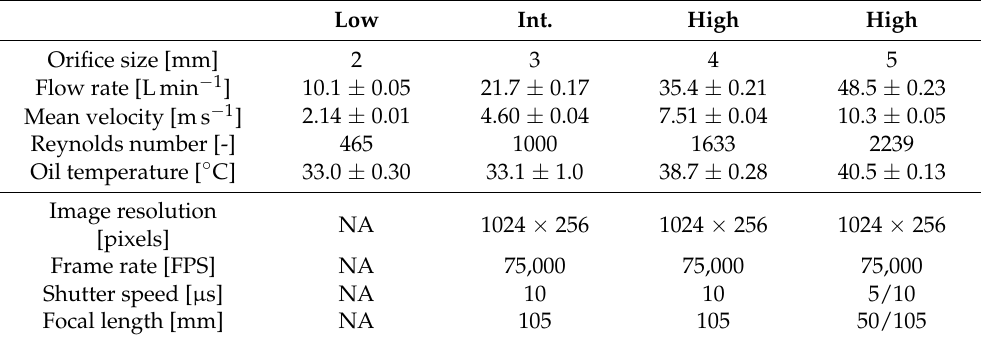
Table 2. Flow rate and temperature measurements (given as AVG ± STD) for the different orifice sizes. The Reynolds number ( Re ) was based on a kinematic viscosity of 4.6 × 10 − 5 m 2 s − 1 and inner pipe diameter. At the highest flow rate, two sets of data were obtained with different shutter speed and focal length (denoted low/high). Low